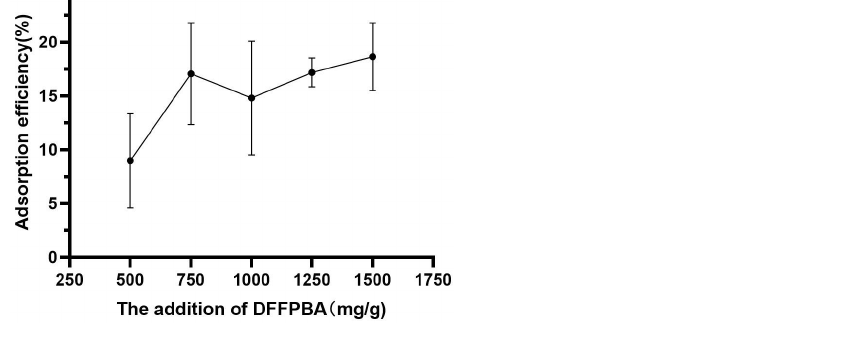
Figure 4. The effect of DFPBA content on the absorption efficiency of prepared paper@epoxy@PEI- DFFPBA to tea polyphenol. The error bars show standard deviations.